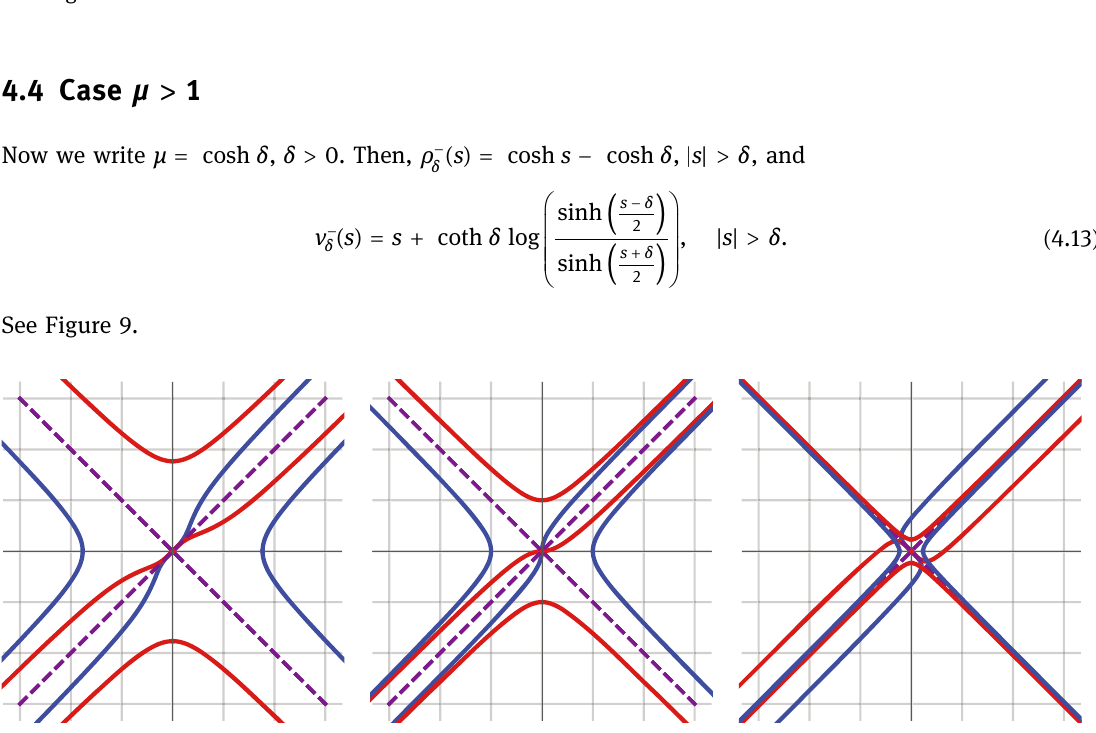
Figure 8: Spacelike ( blue ) and timelike ( red ) curves in (cid:2) 2 such that (cid:2) ( ) =